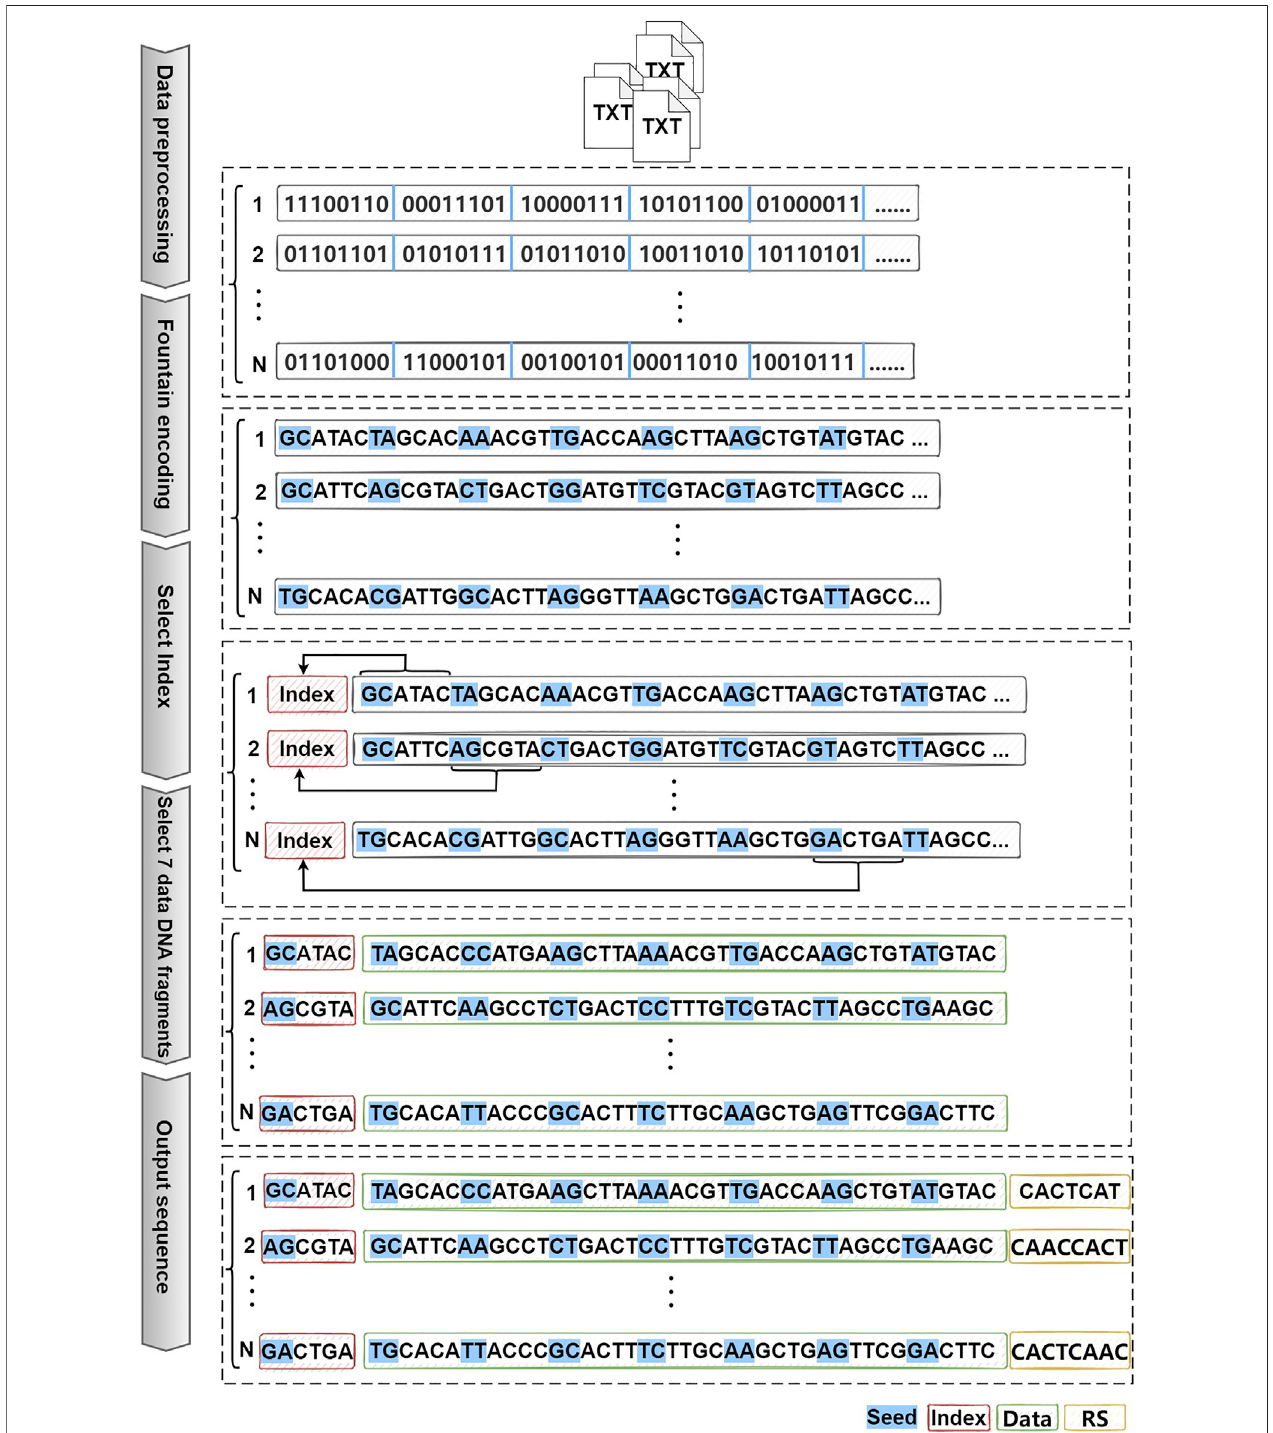
FIGURE 3 | Schematic illustration of an example DNA storage encoding scheme for hidden addressing.